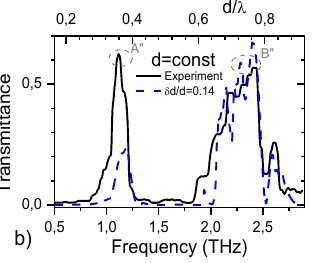
Fig. 4 Fixed d =95  m and R =600  m, TDS transmittance spectra - solid magenta line; dashed blue line – theory for 